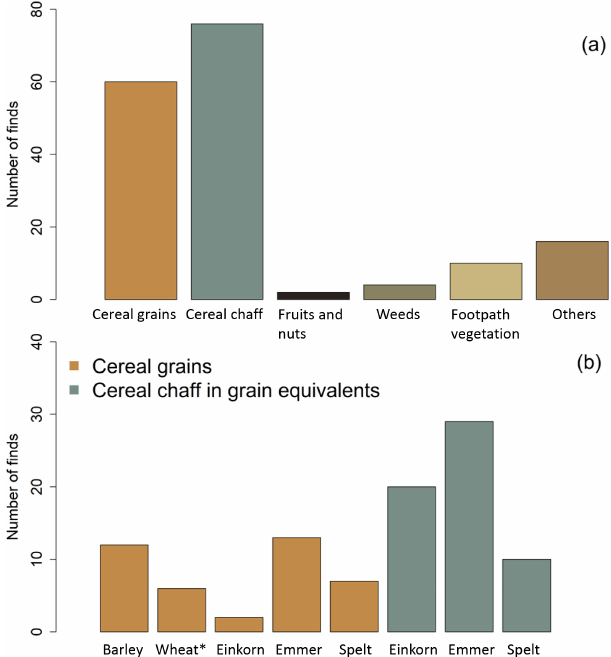
Figure 7. Charred plant macro remains identified in the archaeo- logical features of Anselfingen. Amount of plant macrofossils from the main economic and ecological groups (a) and amount of the main archaeological finds of cereal crops (b) . Wheat ∗ : fresh thresh- ing